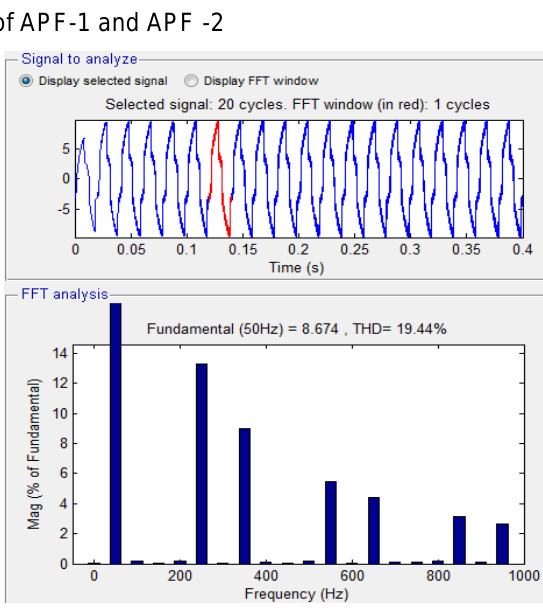
Figure 24. THD in load current The harmonic distortion of source and load current are shown in figure 23 and figure 24 respectively. Load being non-linear distorts load current by 19.44%, while presence of APF forms the source current distorted by 2.41% with respect to